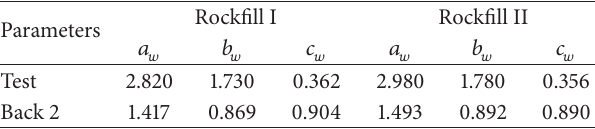
Table 4: Wetting model parameters.